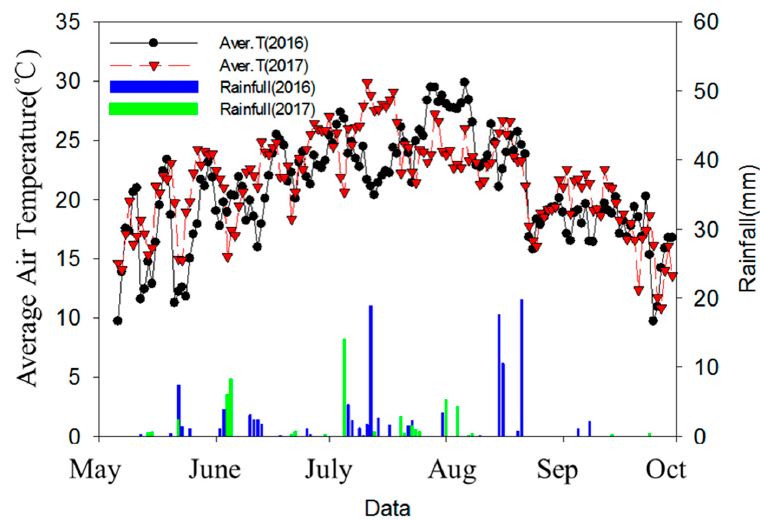
Figure 2. Average air temperature and rainfall distribution during the two growing seasons for maize.